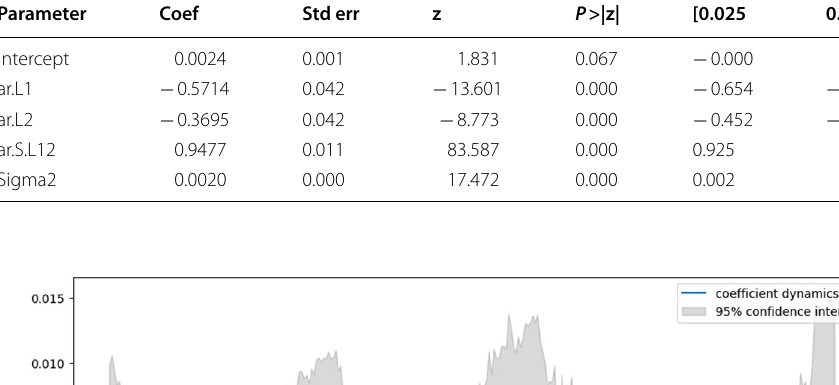
Table 1 Model summary for US e-trade volume Parameter